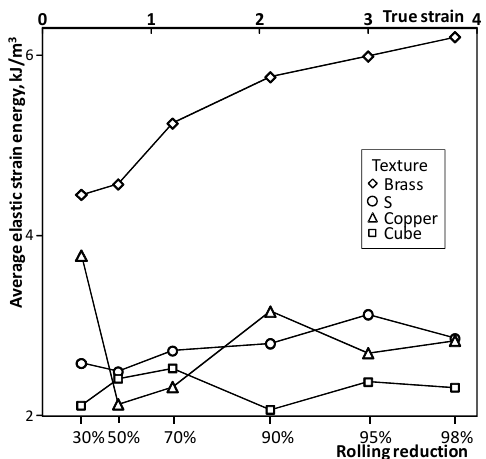
Figure 5. Average elastic energy of grains induced by intergranular mechanical interactions in different texture components during rolling simulation by the RS model ( α 12 = 0.72, α 23 = α 31 = 0 and α 22 = 0.04 for brass, S and copper textures; and α 12 = 0.8, α 23 = 1 and α 31 = α 22 = 0 for cube texture).